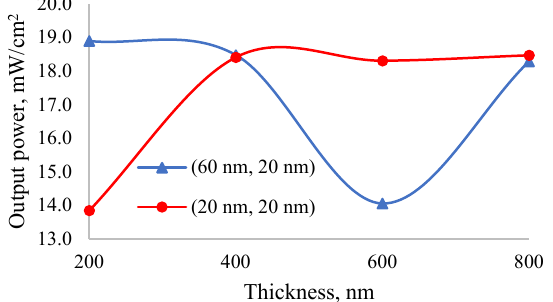
Figure 9. Dependence of output power of solar cell with ETL and HTL layer thicknesses of (60 nm, and 20 nm) and (20 nm, and 20 nm) on perovskite layer thickness.